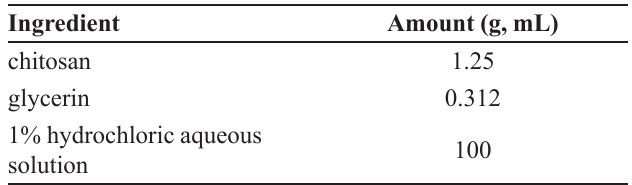
TABLE II - Chitosan subcoating